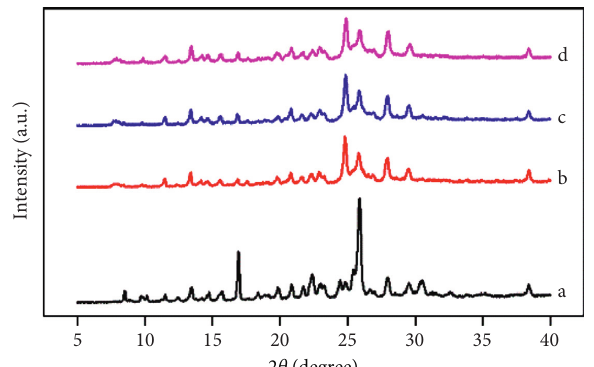
Figure 7: PXRD spectra of Cu (I)-MOF before (a) and after Cr (VI) adsorption through one cycle (b), two cycles (c), and three cycles